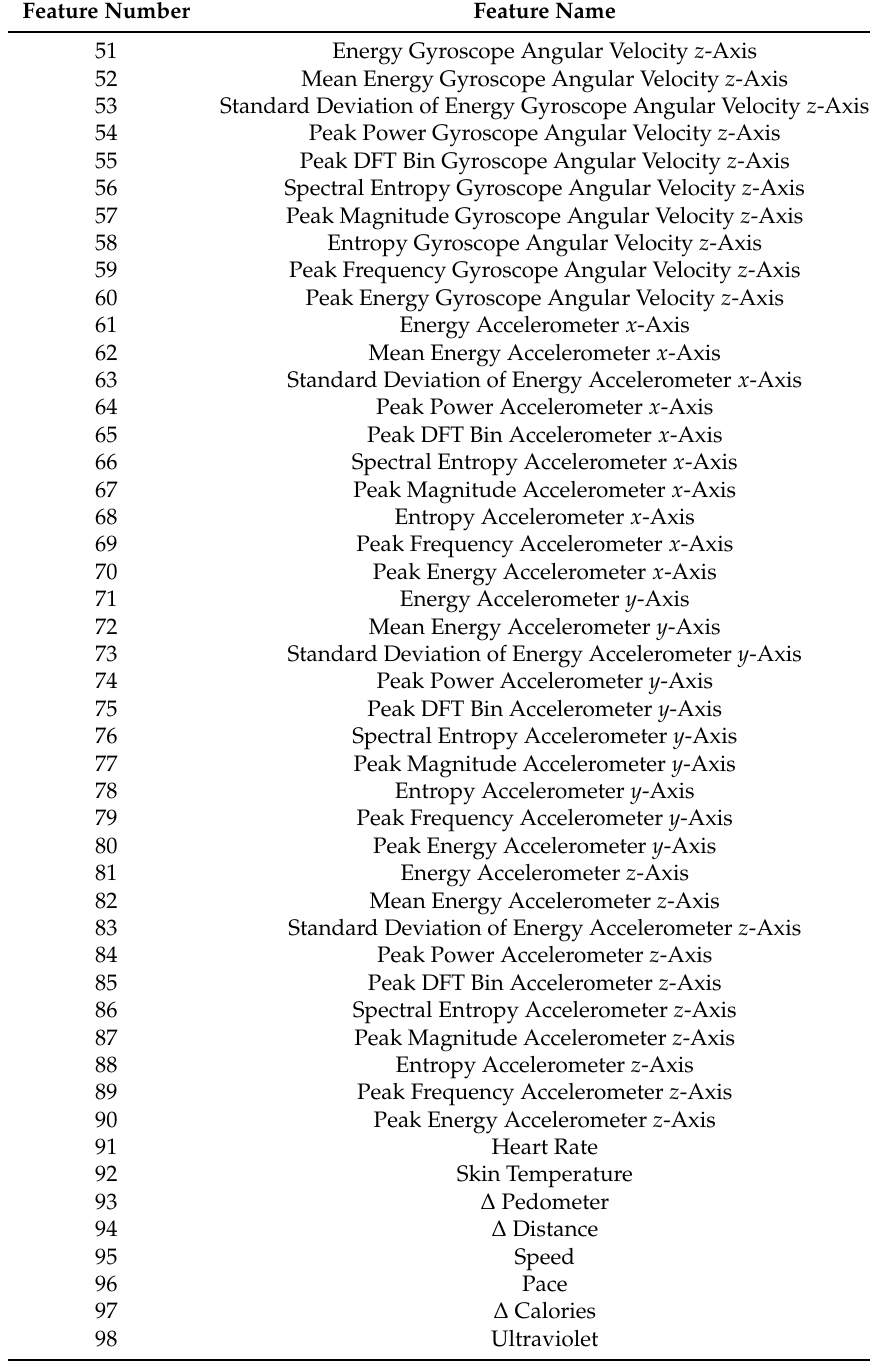
Table A2. Time-/Frequency-domain feature vector part